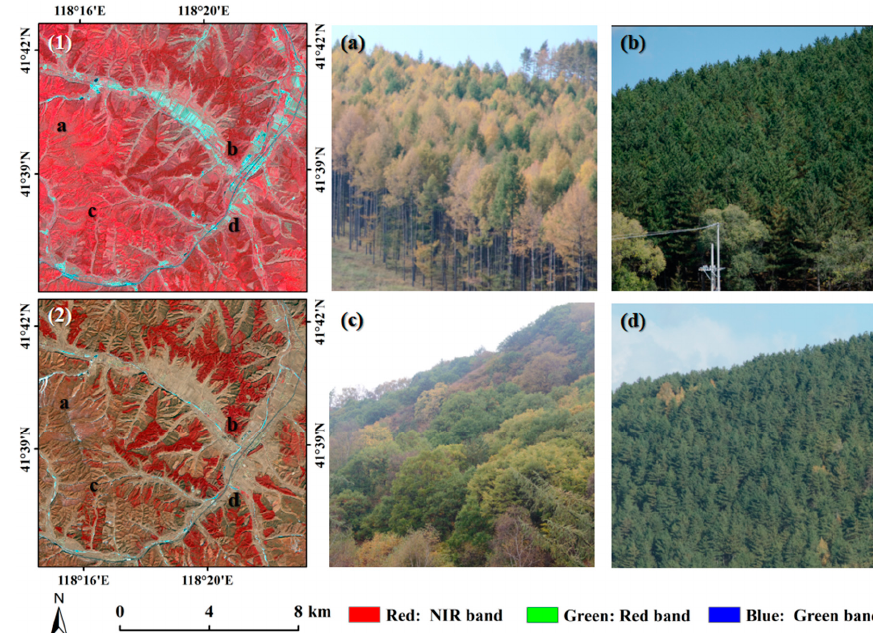
Figure 2. A comparison of color composites in leaf-on season ( 1 ) and leaf-off season ( 2 ) showing different representations of four tree species classes: birch ( a ) Chinese pine ( b ) a composite of different broadleaf tree species ( c ) and larch ( d ).